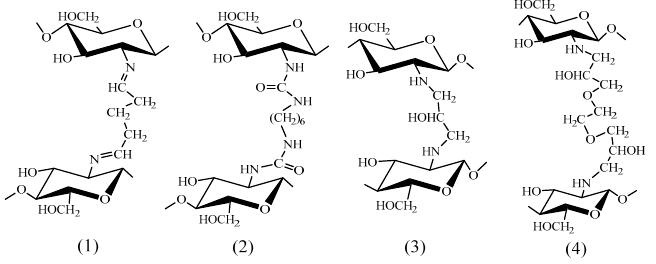
Figure 5. Structural fragments of crosslinked derivatives of chitosan obtained with glutaraldehyde (1), hexamethylene diisocyanate (2), epichlorohydrin (3), and ethylene glycol diglycidyl ether (4).